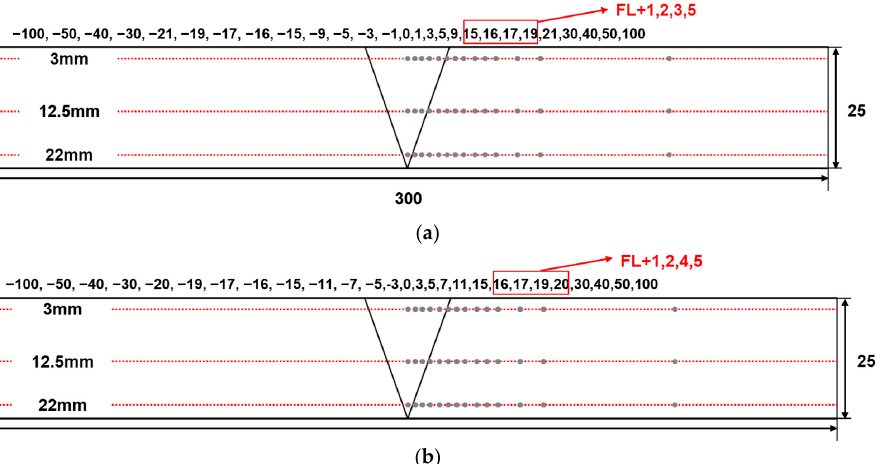
Figure 6. Neutron diffraction measurement points for the specimens. ( a ) Constrained weld specimen; ( b ) unconstrained weld specimen.